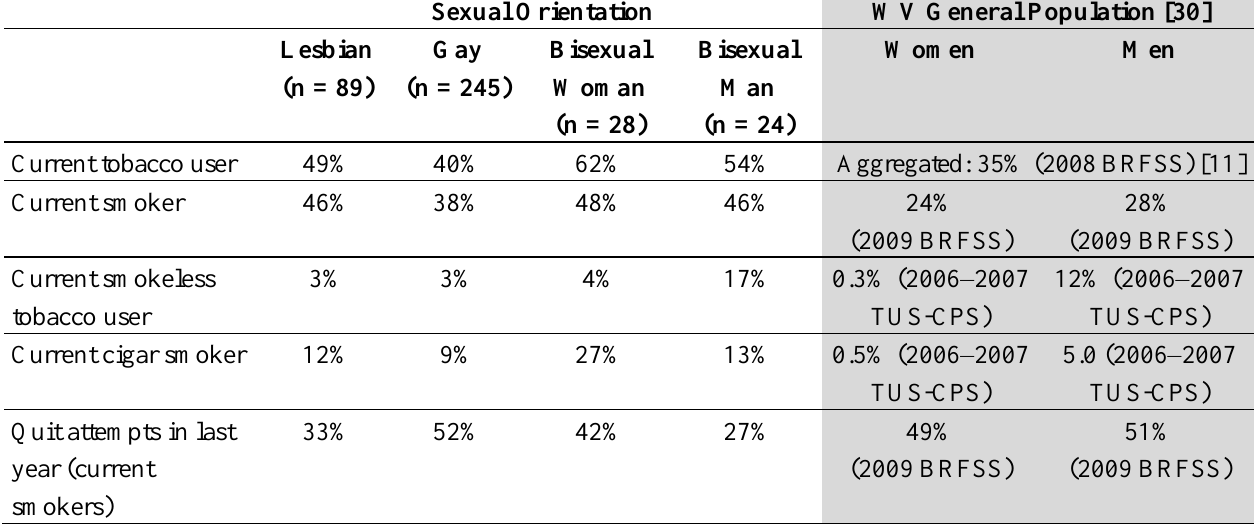
Table 4. LGB tobacco use behaviors and quit attempts by sexual orientation. Sexual Orientation